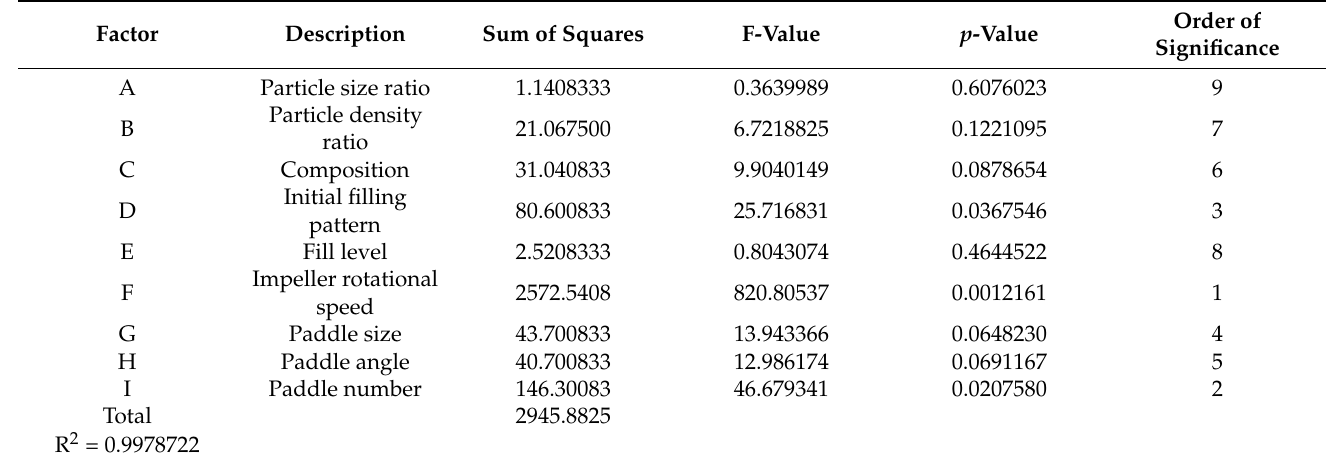
Table 8. Analysis of variance (ANOVA) results of KPI 3 average mixing power.